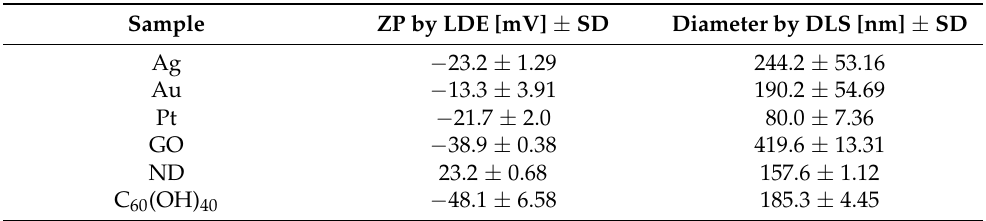
Table 1. Zeta potential (ZP) and the average NPs/agglomerate size in suspension that were measured by laser Doppler electrophoresis (LDE) and dynamic light scattering (DLS), respectively. All of the ZP measurements were performed at an NP concentration of 20 mg/L. The average size of metallic NPs was measured at the concentration of 25 mg/L and that of carbon-based nanomaterials at 20 mg/L. The results are presented as mean with standard division